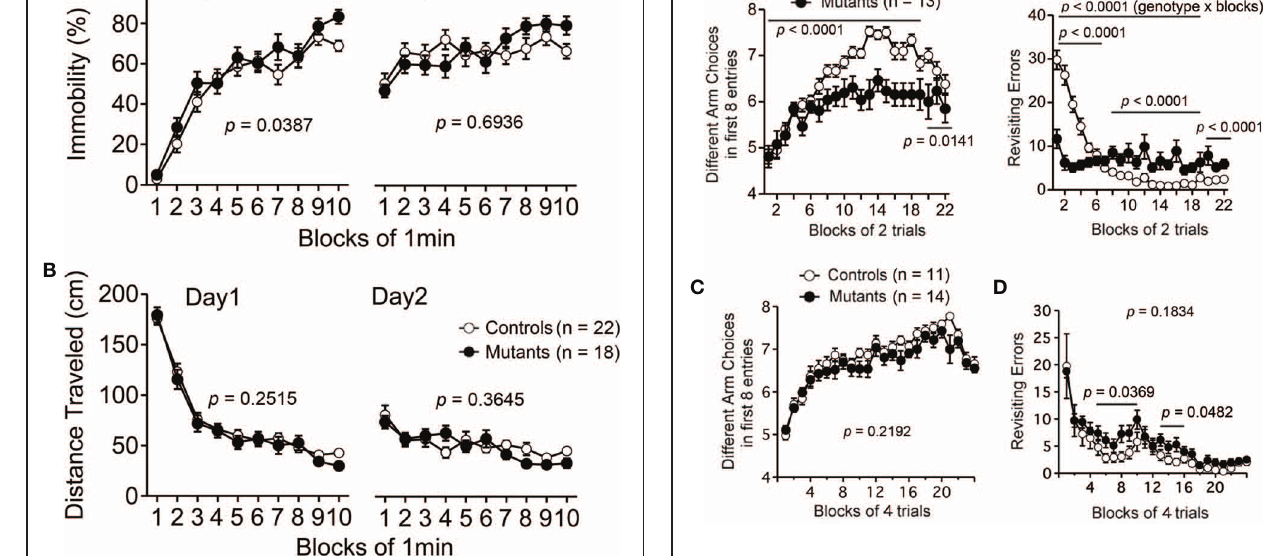
FIGURE 6 | Age-dependent impairment in working memory performance of Apc + / − mice in the eight-arm radial maze test. Adult Apc + / − mice 11–12 weeks of age showed impaired working memory performance (A–B) . (A) Adult Apc + / − mice showed a significant decrease in the number of different arm choices in the first eight entries compared to controls during both trials without a delay (blocks 1–19) and trials with a delay (blocks 20–22). (B) Apc + / − mice exhibited a decrease in the number of revisiting errors during the earlier trials (blocks 1–7), and an increase in the later trials (blocks 8–19) and the trials with a delay (blocks 20–22). There was no significant difference in the number of revisiting errors between genotypes during the whole session. Apc + / − mice, n = 13; wild-type mice, n = 21. Young Apc + / − mice 6–7 weeks of age showed almost intact working memory performance in spatial memory tasks (C–D) . (C) There was no significant difference between genotypes during the whole session in the number of different arm choices the first eight entries. (D) Apc + / − mice exhibited a slight but significant increase in the number of revisiting errors during the earlier trials (blocks 5–10) and the later trials (blocks 13–16). There was no significant difference in the number of revisiting errors between genotypes during the whole session. Apc + / − mice, n = 14; wild-type mice, n =